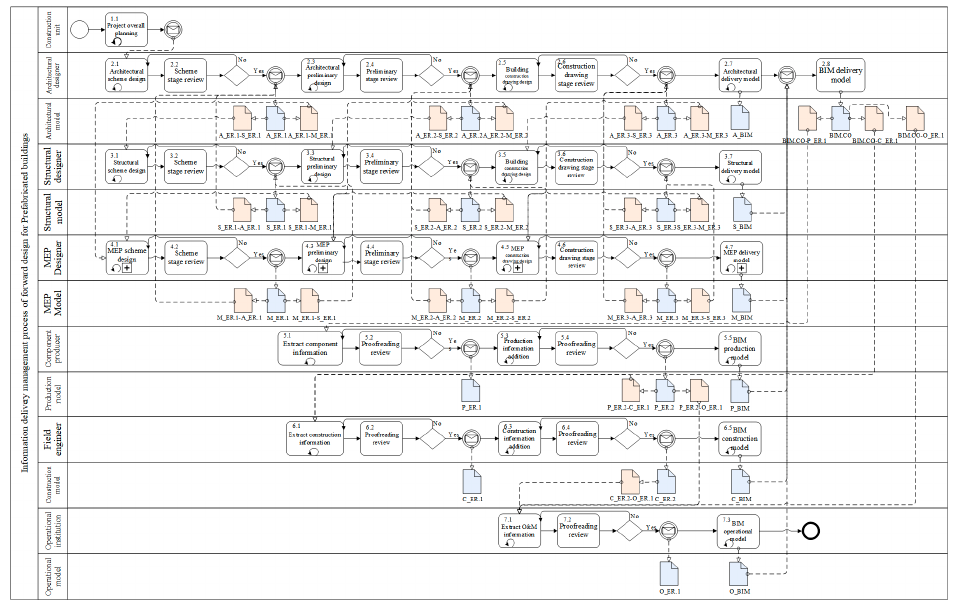
Figure 16. Process of information delivery management of forward design for prefabricated build- ings.